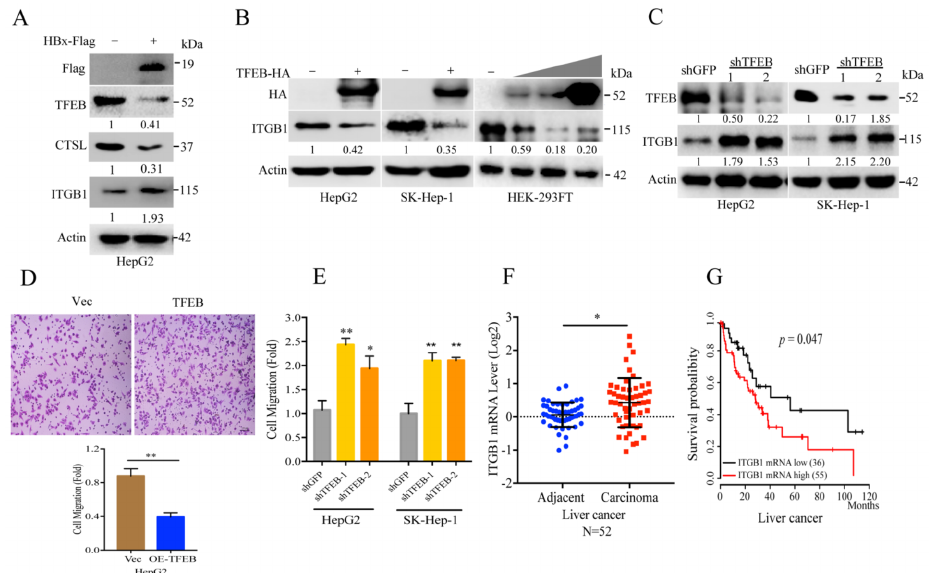
Figure 3. TFEB inhibits cell migration through downregulation of integrin beta 1. ( A ) HepG2 cells stably expressing vector (Vec) or HBx-Flag were subjected to Western blotting analysis for TFEB, CTSL, integrin beta 1 (ITGB1) and actin. ( B ) HepG2 or SK-Hep-1 cells stably expressing TFEB and HEK-293FT transfected with vector control or 0.5, 1, or 2 µ g of TFEB-HA plasmid, were subjected to Western blotting analyses for ITGB1. ( C ) HepG2 or SK-Hep-1 cells were infected by lentivirus to knockdown TFEB, followed by Western blotting analysis for ITGB1. ( D ) HepG2 cells stably expressing TFEB were subjected to transwell assay. The experiment was repeated four times and five visual fields were collected for analysis. ( E ) HepG2 or SK-Hep-1 cells with knockdown of TFEB were subjected to transwell assay. The experiment was repeated three times and five visual fields were collected for analysis. ( F ) The mRNA levels of ITGB1 by the liver cancer samples were retrieved from TCGA database. ( G ) The Kaplan–Meier plots of overall survival (OS) of human liver cancer patients were stratified by ITGB1 mRNA expression levels, the log-rank test. For (D), scale bar = 100 µ m. p Values were showed. * p < 0.05 and ** p <